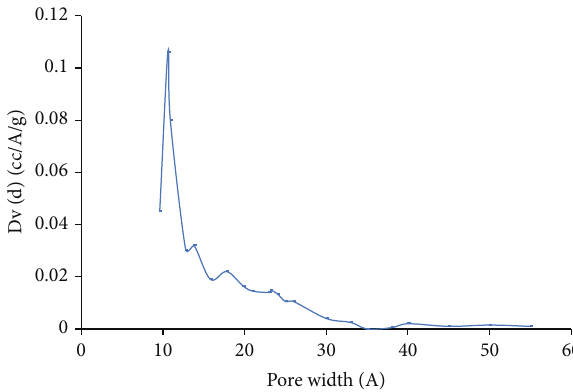
Figure 6: The PSD of the Norit AC derived from N 2 isotherm at 77 K using DFT [8].